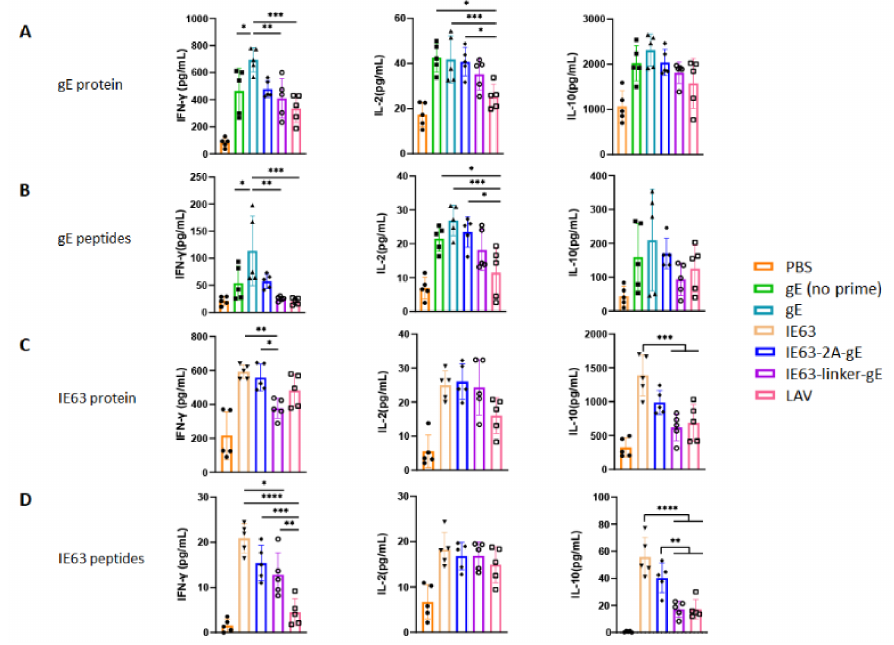
Figure 4. IFN- γ , IL-2, and IL-10 levels in immunized mouse spleen cells. The levels of Th1 (IFN- γ and IL-2) and Th2 (IL-10) cytokines secreted by mouse spleen cells stimulated with gE protein ( A ), gE peptides ( B ), IE63 protein ( C ), and IE63 peptides ( D ) were detected 14 days after the third vaccination. * p < 0.05;